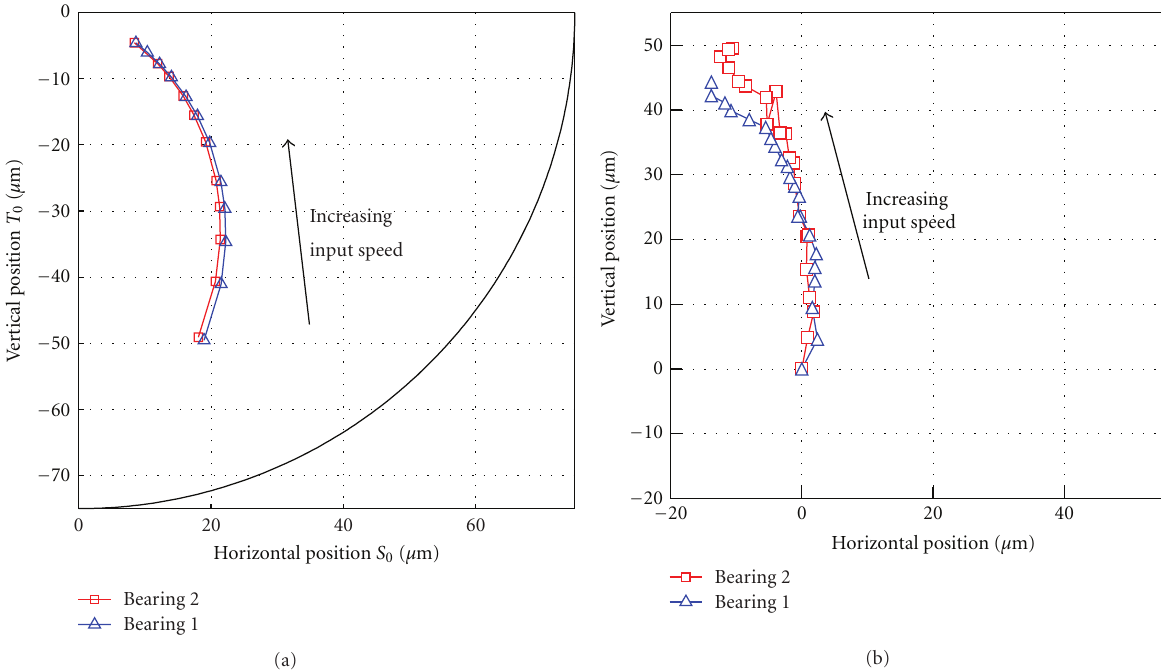
Figure 7: Comparisons of the simulated (a) and measured [16] (b) positions of the shaft centre inside the bearings at static equilibrium, spur gear set, C r = 1540 N · m, 50 rad/s < Ω 1 < 700 rad/s.